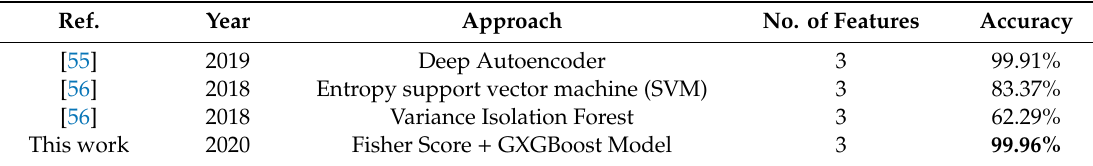
Table 12. Comparison of results with related works for attack and benign classification tasks. Ref.